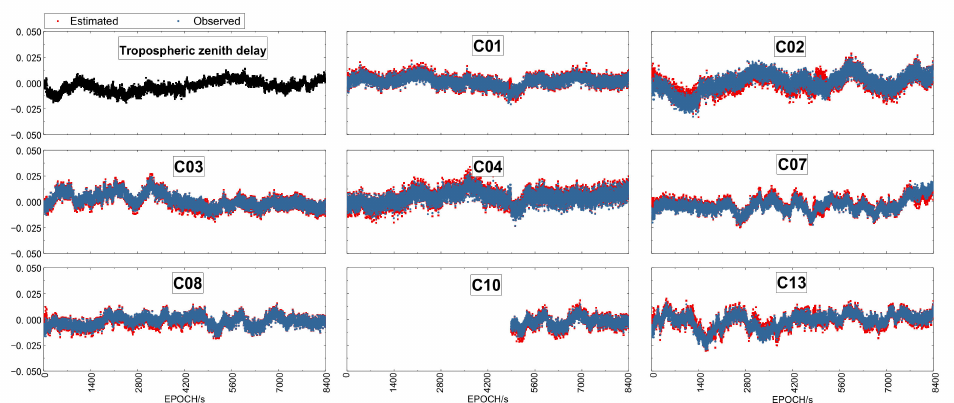
Figure 2. The top-left panel shows the estimated tropospheric zenith delay, and the other panels illustrated the ionospheric delays derived from B1/B2 phase observations aligned to the and the estimated slant ionospheric delay (red) for all the satellites over baseline C1 processed in kinematic mode in 10-min sessions. The estimates before ambiguity-fixing are not plotted.